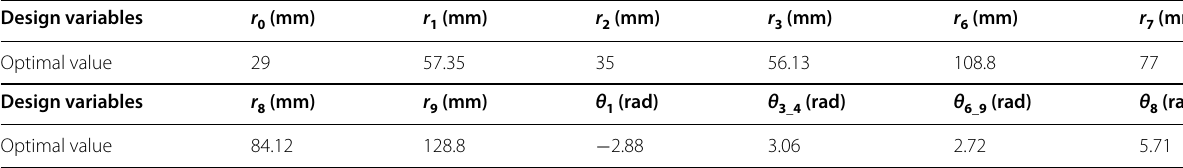
Table 2 Optimum values of design variables Design variables